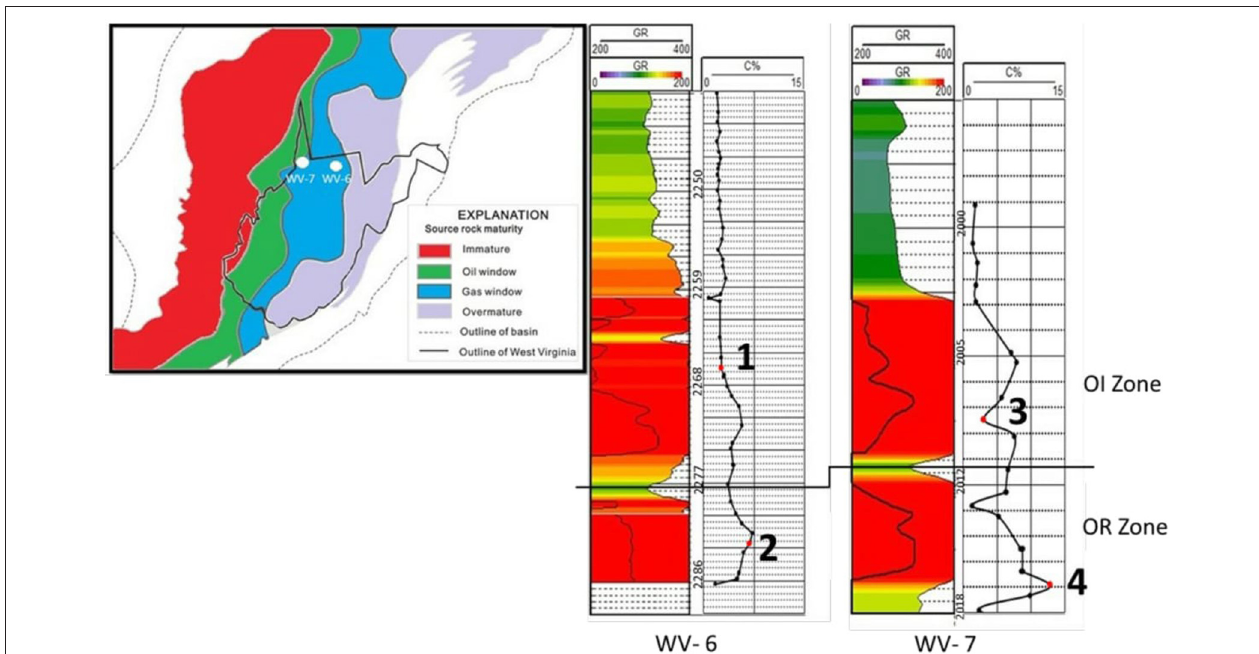
FIGURE 1 | Samples for biomarker analysis are marked in red. Samples marked as 1, 3 are from OI (organic intermediate) zone while 2 and 4 are from OR (organic rich) zone. Samples marked by black dots in both zones were collected at approximately at 1 meter intervals for SRA analysis. This figure is modified from Chen et al. (2015)